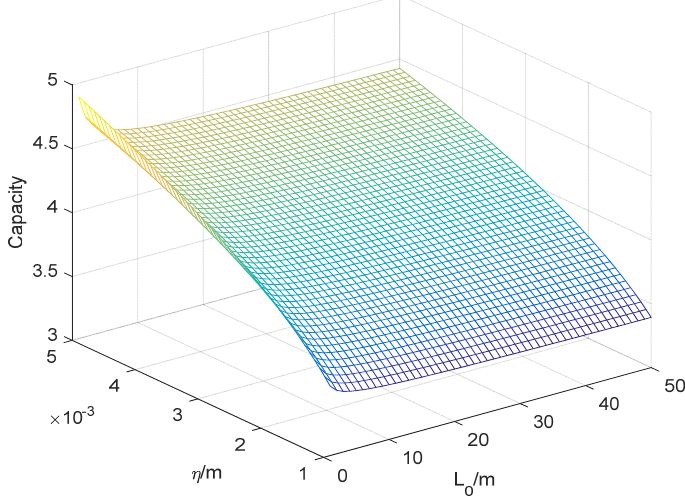
Figure 9. Channel capacity of the link with the random double-position power Gaussian vortex carrier optics communication system versus the inner scale of turbulence η and the outer scale of turbulence L 0